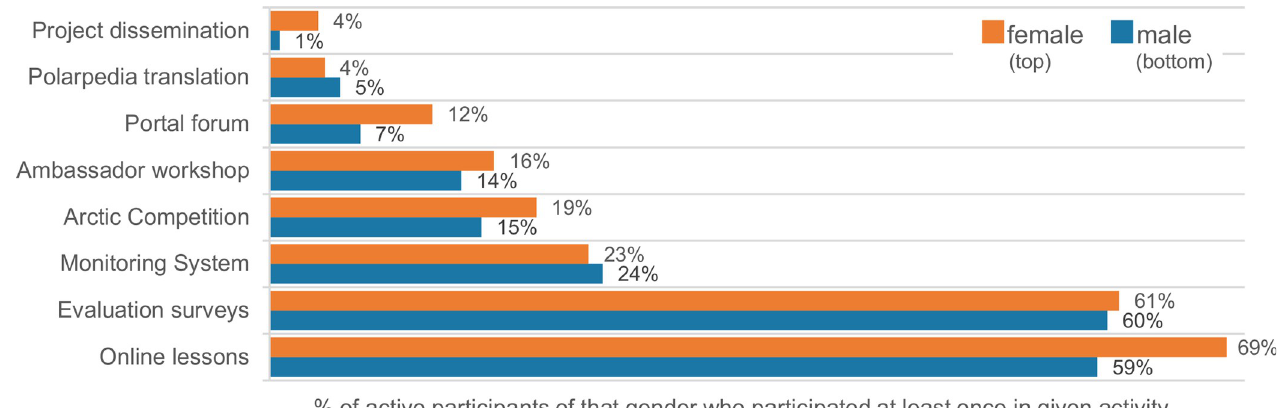
Fig 4. Participation in various activities of male and female teachers in the open online course EDU-ARCTIC (2016–2019). Percentages are based on active teachers, and calculated per gender (N = 412 females, 135 males).